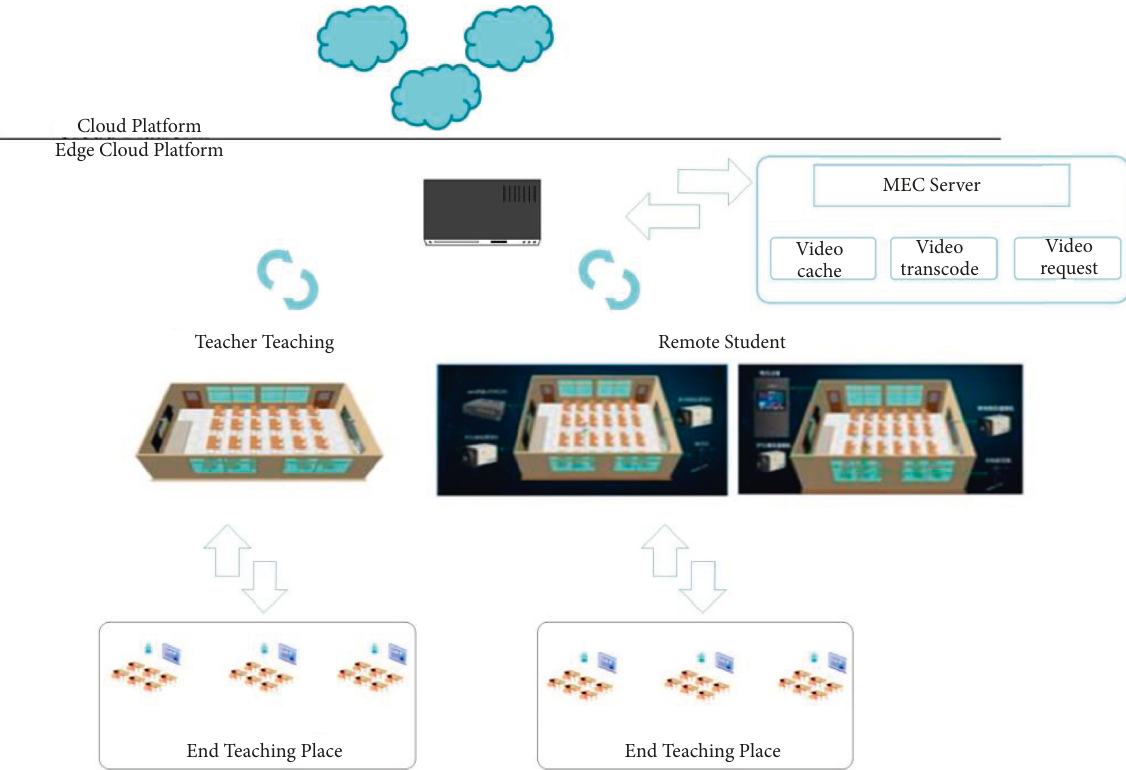
Figure 4: Distance teaching mode of art and painting